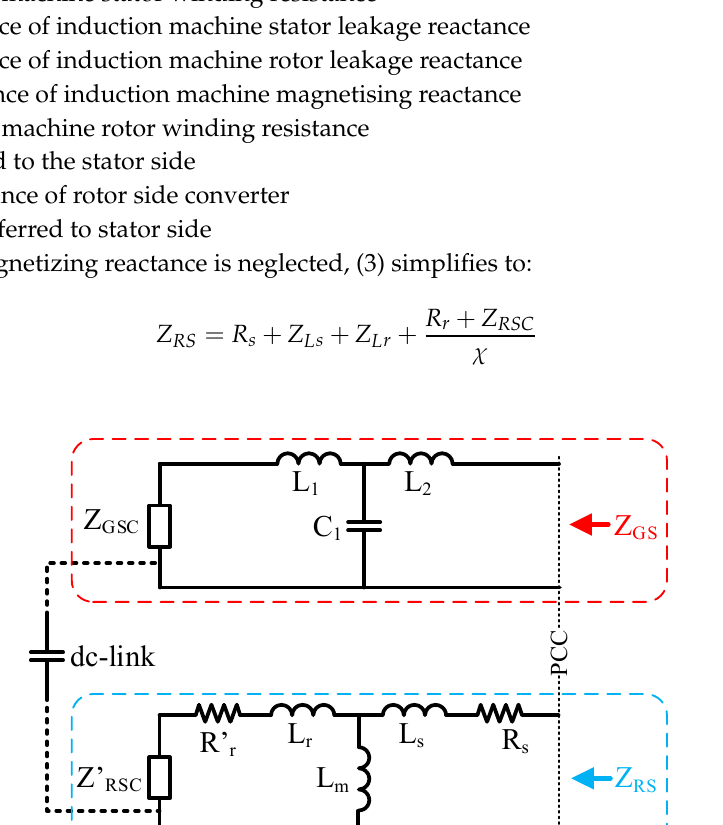
Figure 1. Current classification of subsynchronous oscillations based on [8,13]. Solid boxes represent SSO phenomena that are electromechanical in nature. Dashed boxes represent electromagnetic phenomena.